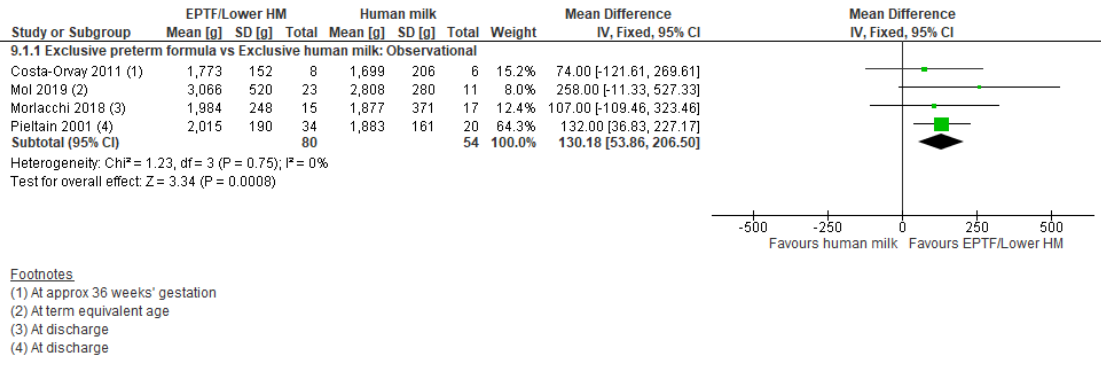
Figure 9. Forest plot of mean difference in change in fat-free mass (g) and human milk intake.